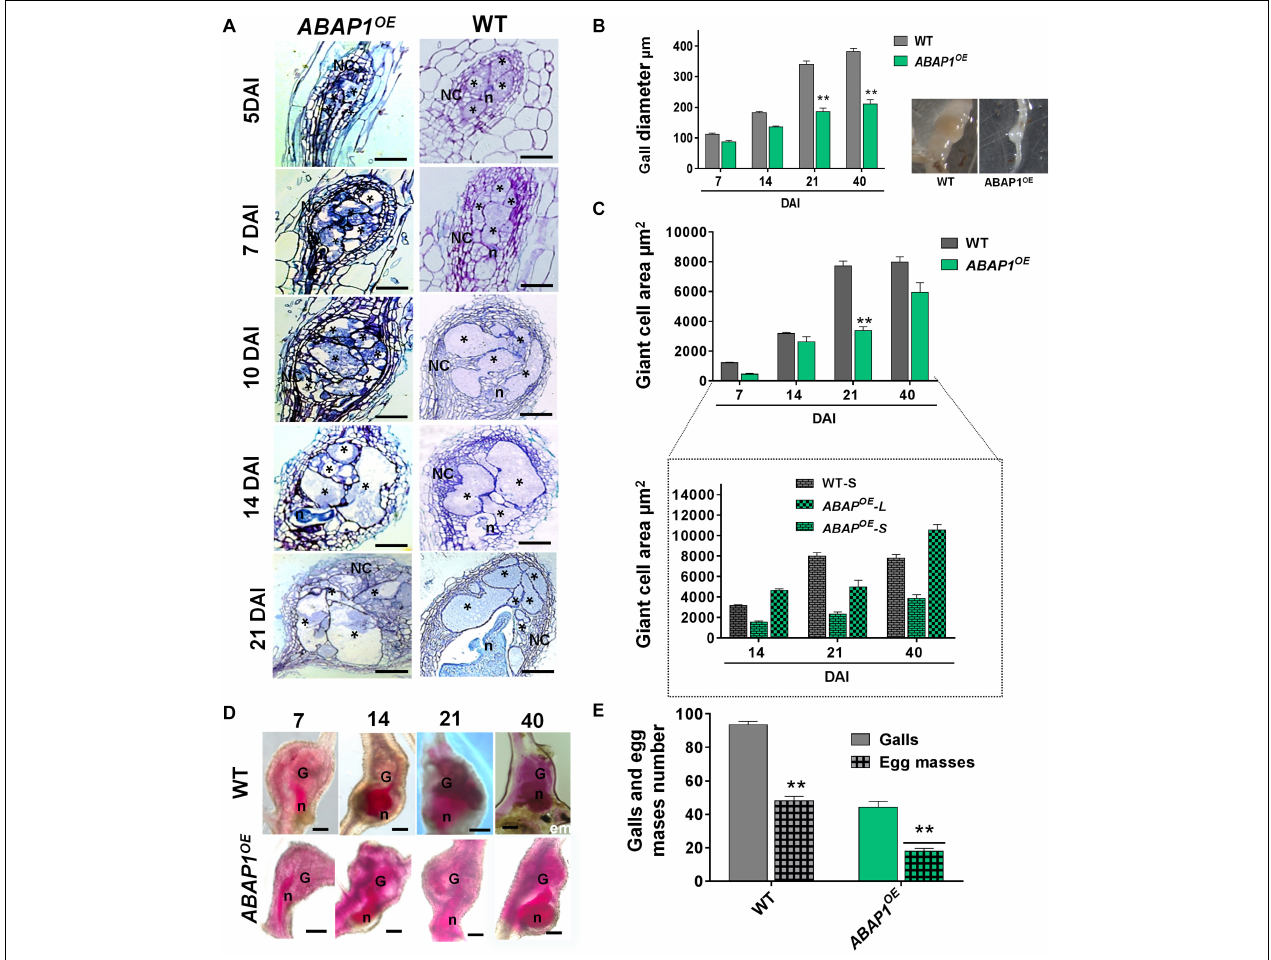
FIGURE 5 | Ectopic ABAP1 expression affects gall morphology and revealed feeding sites with reduced sizes leading to decreased nematode reproduction. (A) Histological analysis of galls overexpressing ABAP1 OE compared to wild-type (WT) at different stages of nematode infection (5, 7, 10, 14, and 21 DAI). Bright-field micrographs show longitudinal gall sections stained with toluidine blue. (B,C) Gall diameter and giant cell area of ABAP1 OE galls compared with WT. Note that galls from ABAP1 OE are smaller than WT galls and two sizes categories of giant cells in ABAP1 OE were observed: small and cytoplasm filled giant cells ( ABAP1 OE -S ) and large containing large vacuoles ( ABAP1 OE -L ). (D) Acid fuchsin staining of ABAP1 OE and WT galls at different developmental stages (7, 14, 21, 40 DAI) of nematode development. A visible delay or arrest in nematode development is seen in the ABAP1 OE line consequently inhibiting and delaying egg mass laying. (E) Nematode infection tests of ABAP1 OE showed a significant decrease in galls and egg masses numbers compared to the WT. Data shown represent means ± SD from two experiments with n = 20 plants per line. Statistical differences are marked with * P < 0.05) or ** P < 0.01 based on Student’s t -test